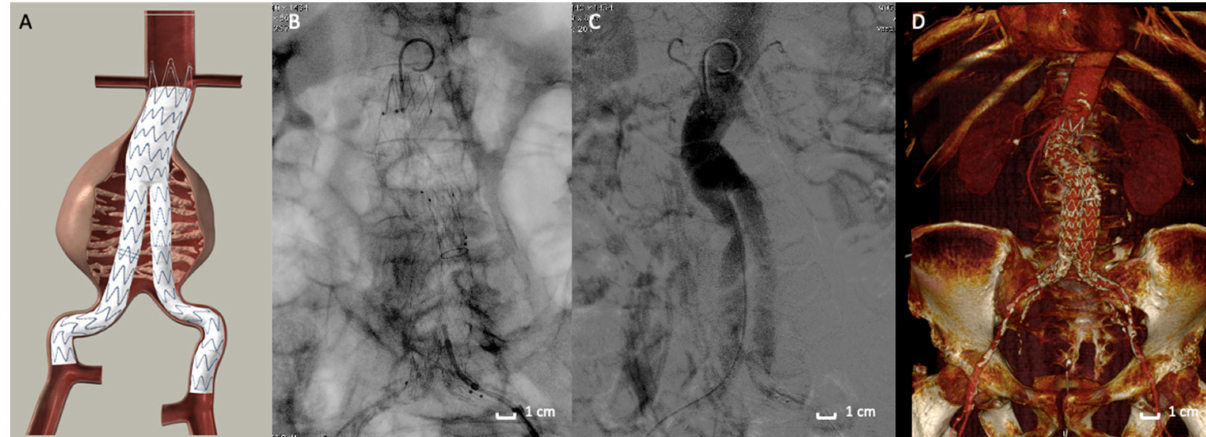
Figure 1. Traditional stent-graft design. ( A ) Picture of the endograft deployed in Abdominal Aortic Aneurysm. Traditional Endovascular aneurysm repair (EVAR) devices employ self-expanding stent structures to promote graft-to-aortic wall apposition (seal) and fixation. ( B ) Intraoperative fluoroscopic image of the endograft deployed in the abdominal aortic aneurysm (AAA). ( C ) Angiographic acquisition that reveals a good exclusion of the AAA and the good patency of the endograft. ( D ) 3D volume rendering of Computed Tomography Angiography at 1-month follow-up that shows the correct aneurysm exclusion.